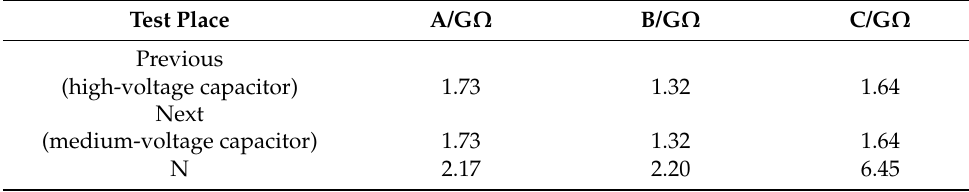
Table 3. Dielectric loss and capacitance test results. Table 2. Insulation resistance test results.